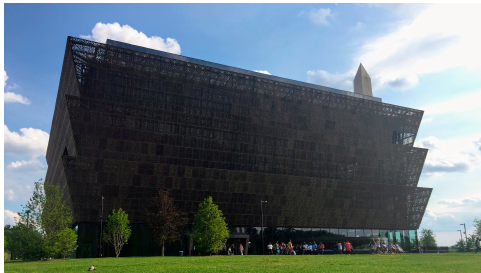
Figure 1. An exterior view of the National Museum of African American History and Culture with the Washington Monument in the background, June 2017.